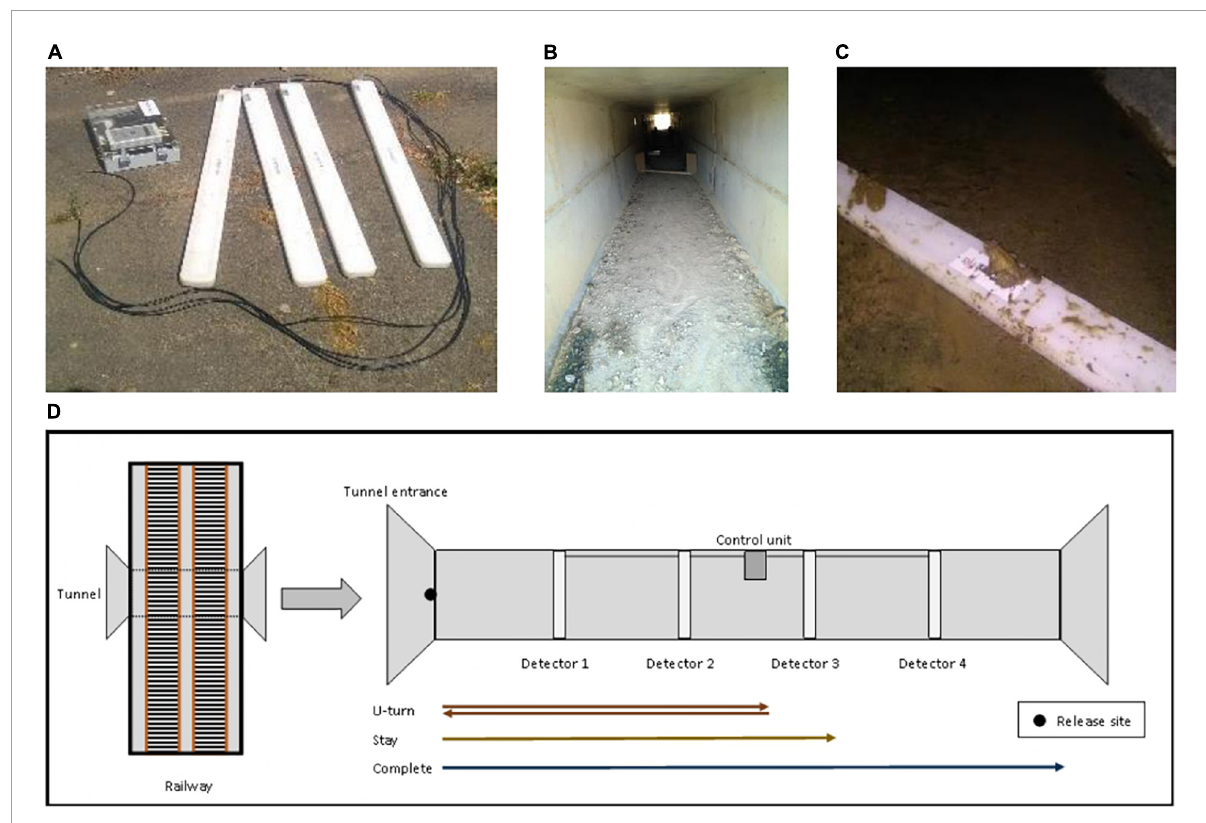
FIGURE1 (A) The four antennas of the RFID device implemented in tunnels. (B) Internal view of one equipped tunnel. Wooden reflectors, set up on either end of one antenna, are visible. (C) A spined toad crossing one antenna. (D) Schematic view of the experiment. U-turn, Stay, and Complete are the behavioral categories recorded in the equipped